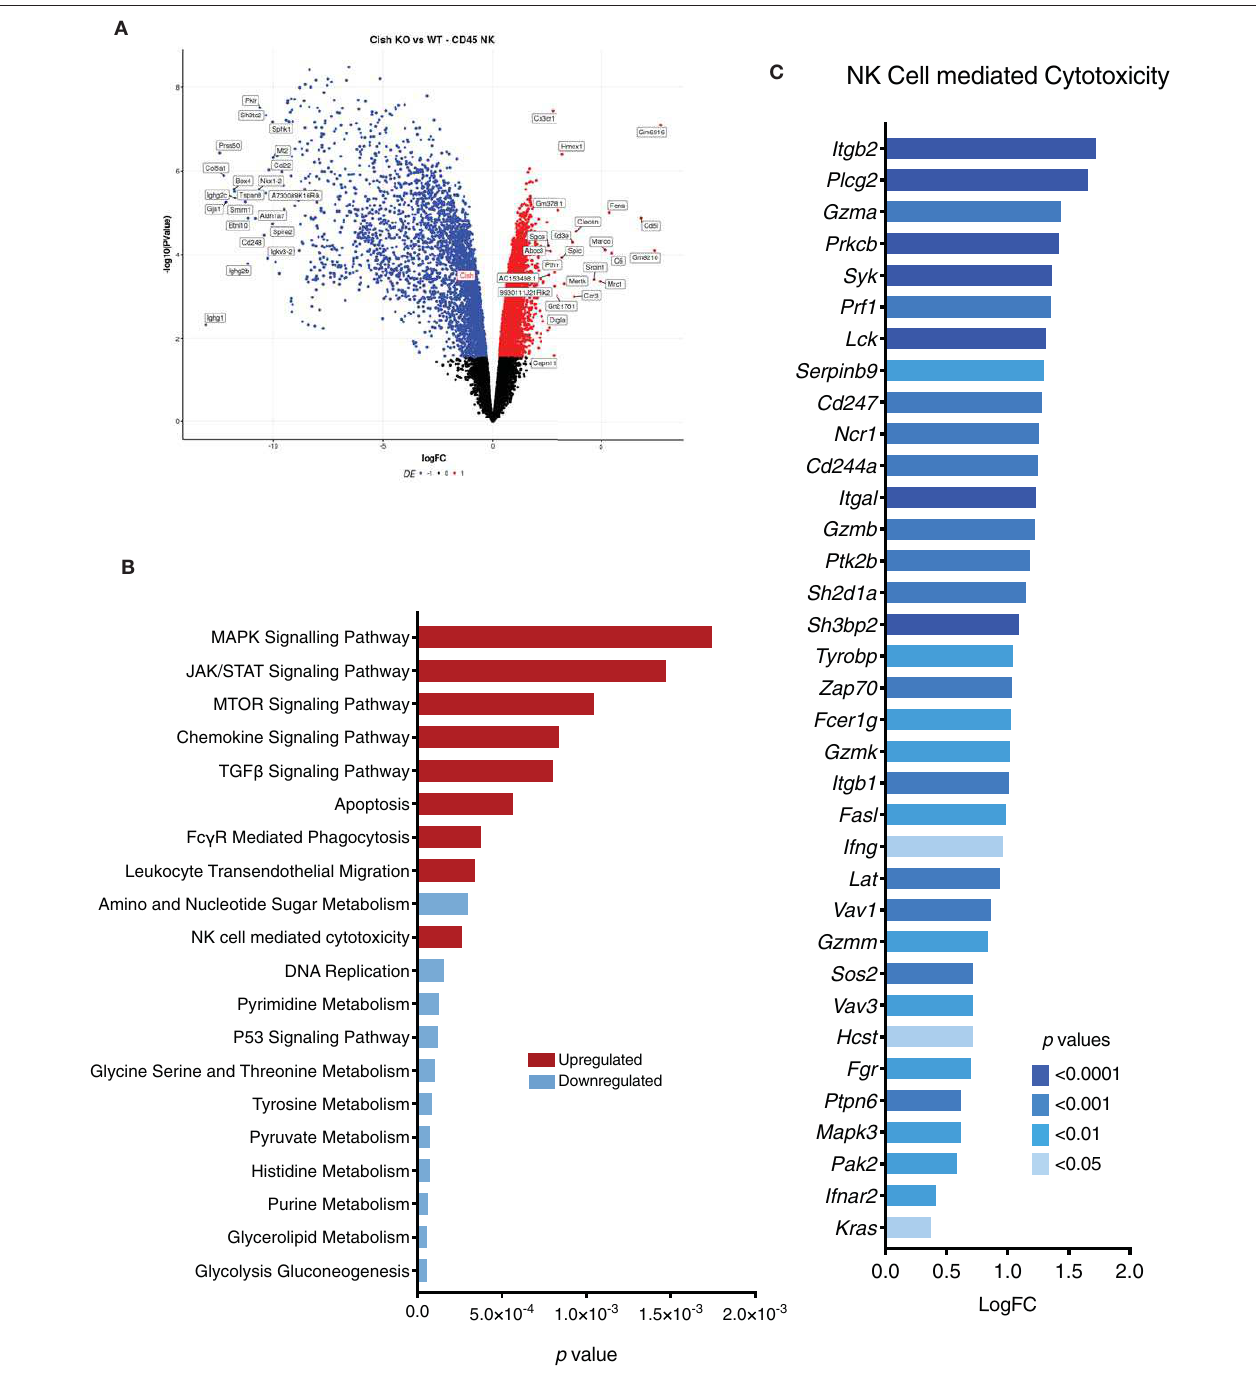
FIGURE 5 | CIS regulates global gene expression in NK cells. Gene expression profiles of sorted NK cells were generated using RNA-sequencing. (A) A volcano plot of the top 50 significant ( p < 0.05) differentially expressed genes with a fold change above + 1 or below − 1 was generated. y-axis is the negative log- p -value and x-axis is the log-fold-change of the corresponding gene in Cish − / − vs Cish + / + comparison. Gene expression: blue = downregulated, red = upregulated. (B) A list of genes was generated using a p -value of < 0.05 and a cutoff of log(FC) = 1.5. The resulting genes were run through KEGG pathway analysis and 20 of the top enriched KEGG pathways with a p -value of < 0.01 were plotted. The height of the bar indicates the significance ( p -value). Pathways: blue = downregulated in Cish − / − , red = upregulated in Cish − / − . (C) An upregulated list of genes associated with NK cell cytotoxicity (from KEGG pathway analysis) was generated with a p- value cut-off of < 0.05. x-axis is the log(FC) of each gene and p -values are indicated by color.